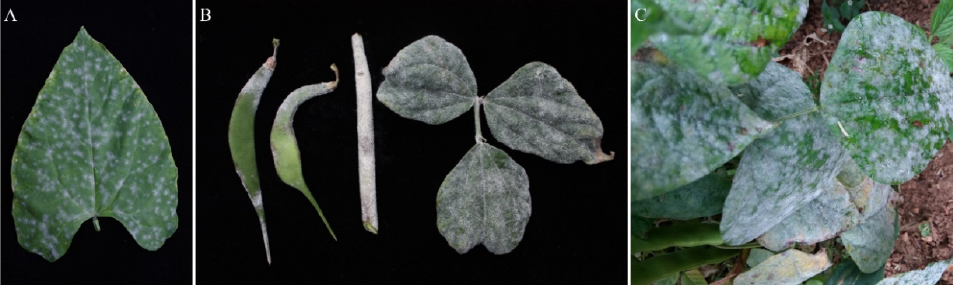
Figure 1. Powdery mildew symptoms on common bean. ( A ) Powdery mildew blotches on a primary leaf by natural infection in glasshouse; ( B ) Symptoms on pods, stem, and leaves developed from pathogenicity test; ( C ) Symptoms on plant observed in